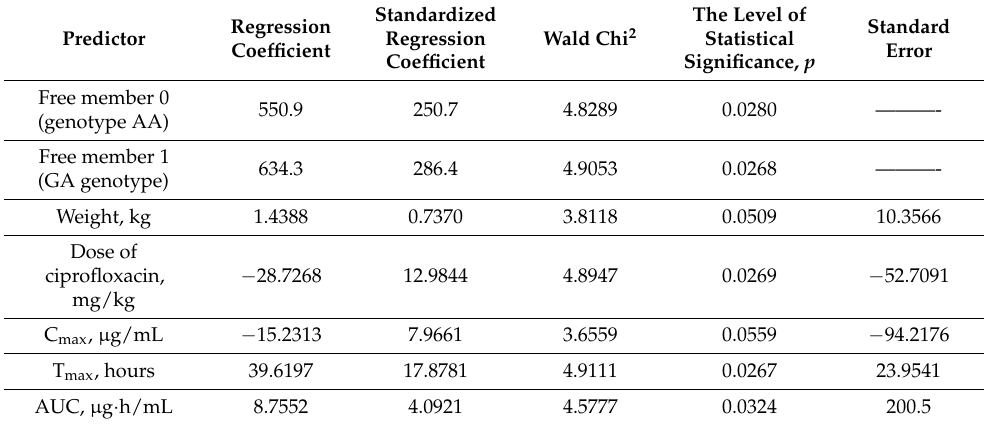
Table 11. Estimatedlogisticregressionparametersforthedependentvariable“GSTP1genepolymorphism”.